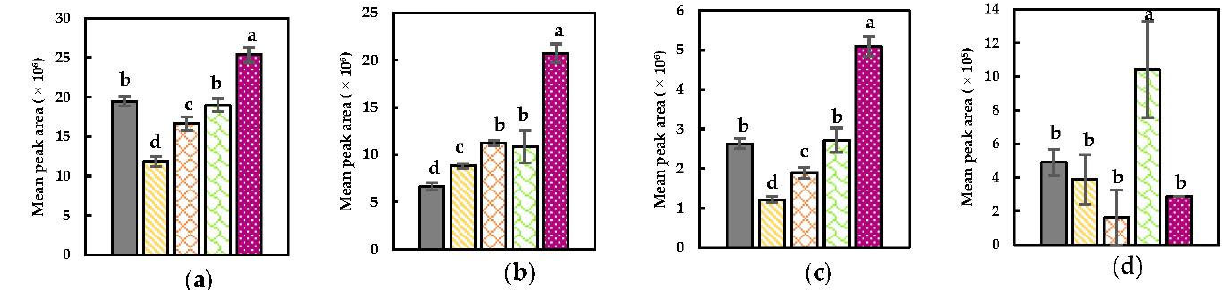
Figure 5. Specific compound plots of selected discriminant nitriles in the headspace of differently PEF ‐ treated Brussels sprouts (( ) NoPEF ( ), 1.01 kV/cm and 2.7 kJ/kg, ( ) 1.01 kV/cm and 27 kJ/kg, ( ) 3.00 kV/cm and 2.8 kJ/kg, and ( ) 3.00 kV/cm and 27.7 kJ/kg). ( a ) Benzyl nitrile; ( b ) 2 ‐ butenenitrile; ( c ) 3 ‐ methyl butenenitrile; ( d ) 4 ‐ (methylthio) butanenitrile. Statistically significant dif ‐ ferences are designated by different letters ( 𝑝 < 0.05, 𝑛 = 6).